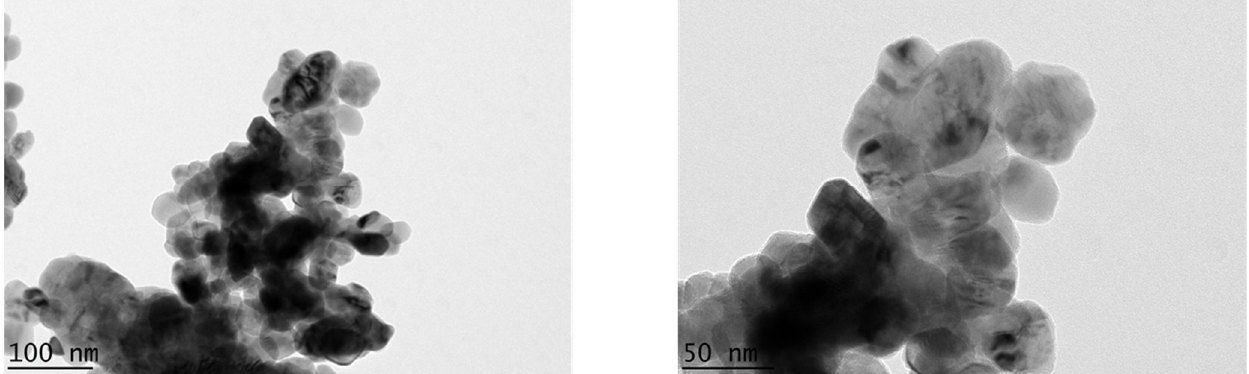
Figure 8. Morphologies of G. mangostana L. leaf extract-mediated synthesized CuO NPs calcinated at 500 °C under TEM.